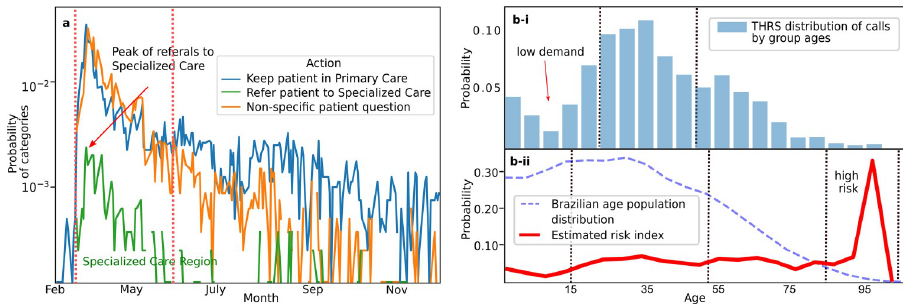
Fig 4. Telemedicine calls over the time with resolutions and patients age teleconsultations. (a) The suggested actions on teleconsultations are divided into: maintaining patient in primary care (observation/isolation) or sending patient to emergency care attention such as Intensive Care Unit (ICU), the rest of the teleconsultations are general practice inquiries. (b) The distribution of patients’ age discussed on teleconsultations and its relation to the Brazilian demographic population. The red line represents a rate between patients ages teleconsultations and Brazilian demographic distribution, the chances of a physician from a medical center to call and discuss patients over 80 years are 5.0 times bigger than the rest of the